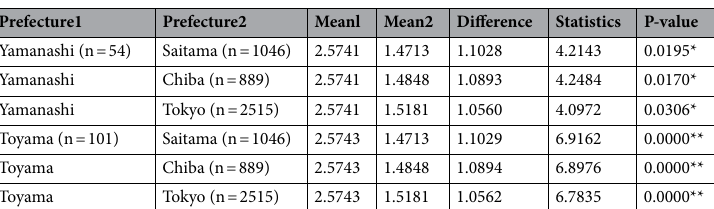
Table 5. Multiple comparison tests for Yamanashi, Toyama, and Tokyo metropolitan area. *P < 0.05, **P <